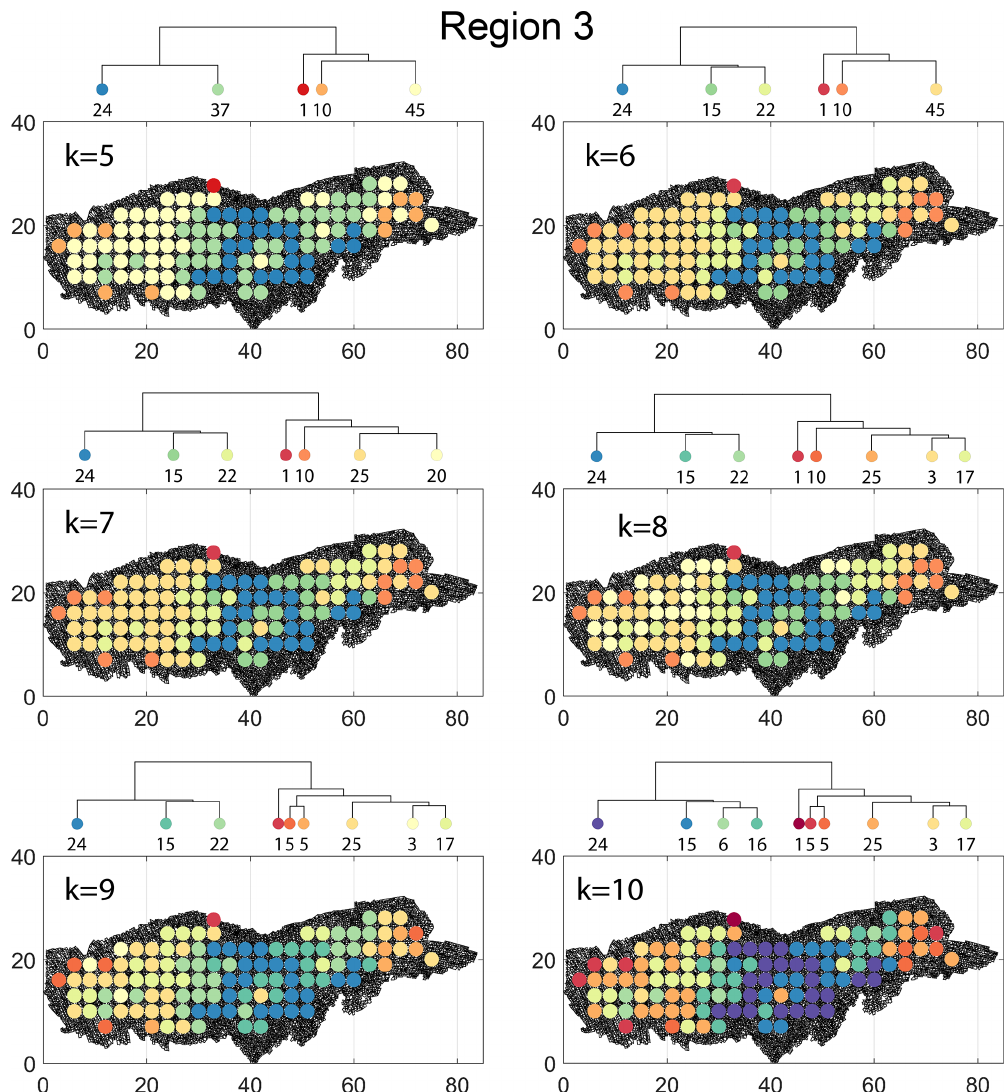
Figure B10. Variation in cluster boundaries for “ k ” clusters in Region 3 using